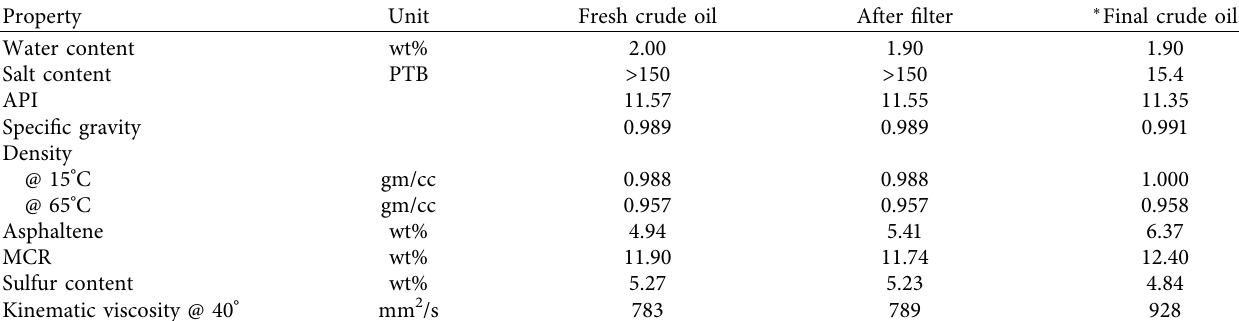
Table 2: Crude oil properties and feedstock preparation.